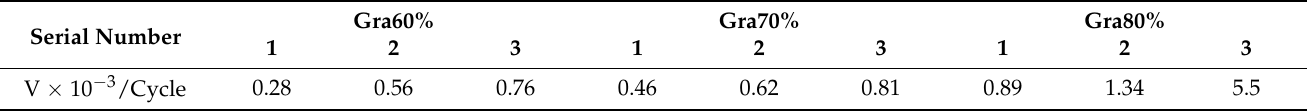
Table 7. Rates of change of the damage